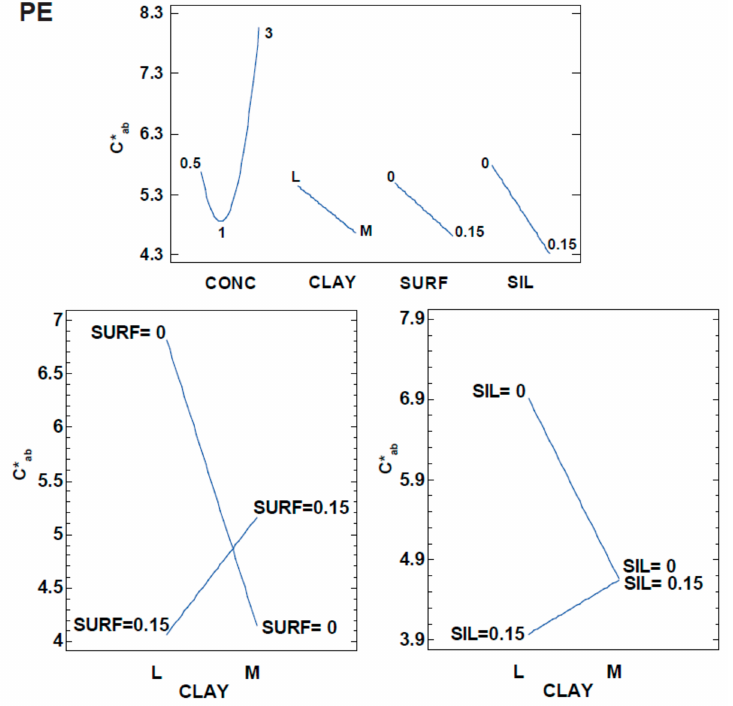
Figure 8. Main effects and interactions plots from the C ab * response in the PE